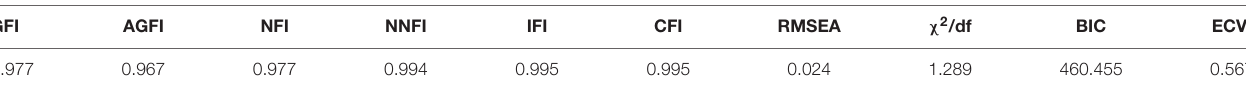
TABLE 5 | Bollen–Stine χ 2 modify model